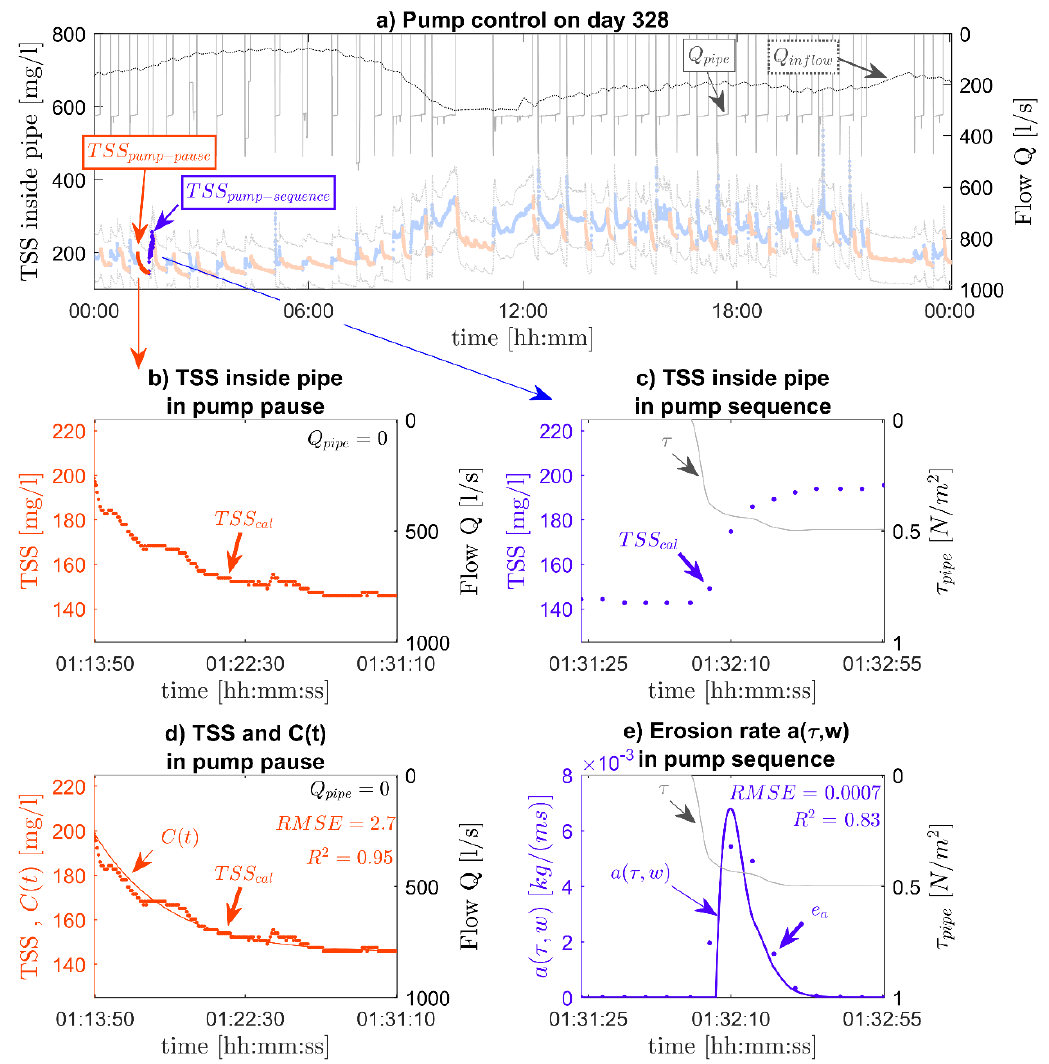
Figure 6. Monitored data in PS Rostock-Schmarl for day 328 ( a ) including exemplary erosion and settling determination scheme ( b – e ). ( a ) Q inflow and Q pipe (right axis) and TSS sensor data including 95% confidence levels (left axis). ( b ) Settling event: TSS values ( TSS cal ) after pumps stop in the night. ( c ) Erosion event: TSS values ( TSS cal ) after pumps start at night. ( d ) Settling event determination: TSS values ( TSS cal ) and approximated settling rate C ( t ) including fit results. ( e ) Erosion event determination: erosion rate e a and approximated erosion rate a ( τ , w ) including fit results.